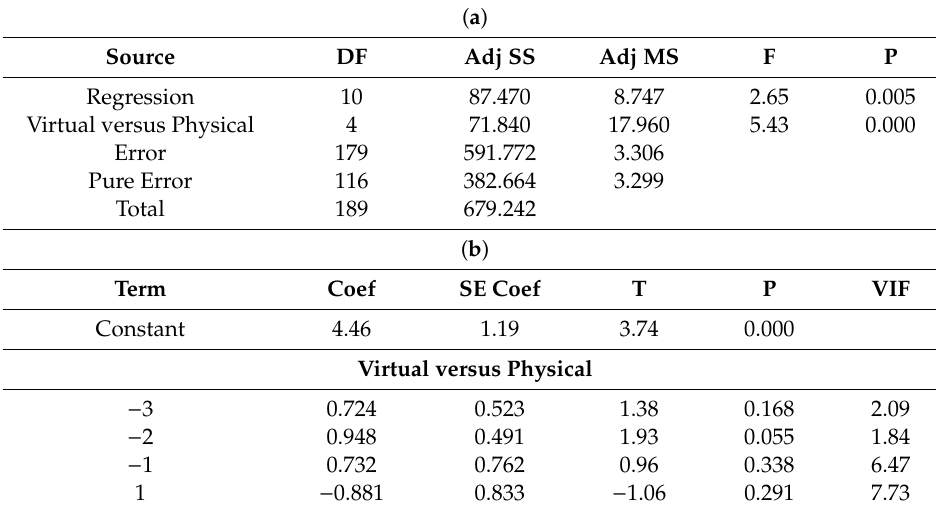
Table 9. ( a ) ANOVA for the arousal construct of the cleaning task with di ff erent feedbacks. ( b ) Multiple comparisons of the arousal construct for integrated